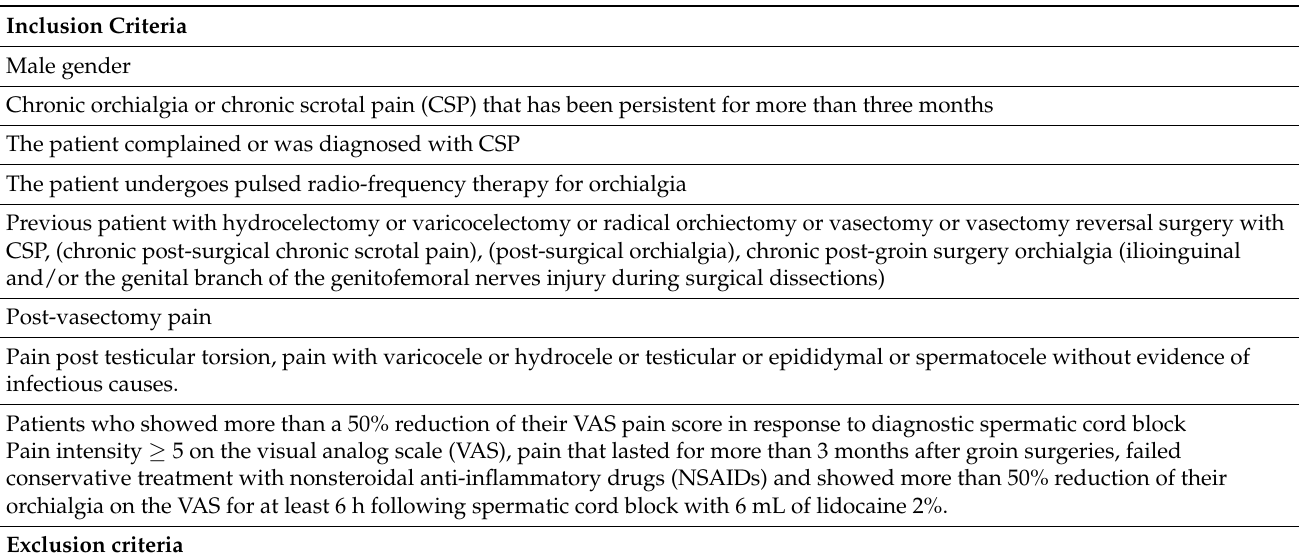
Table 1. Inclusion and exclusion criteria of reviewed